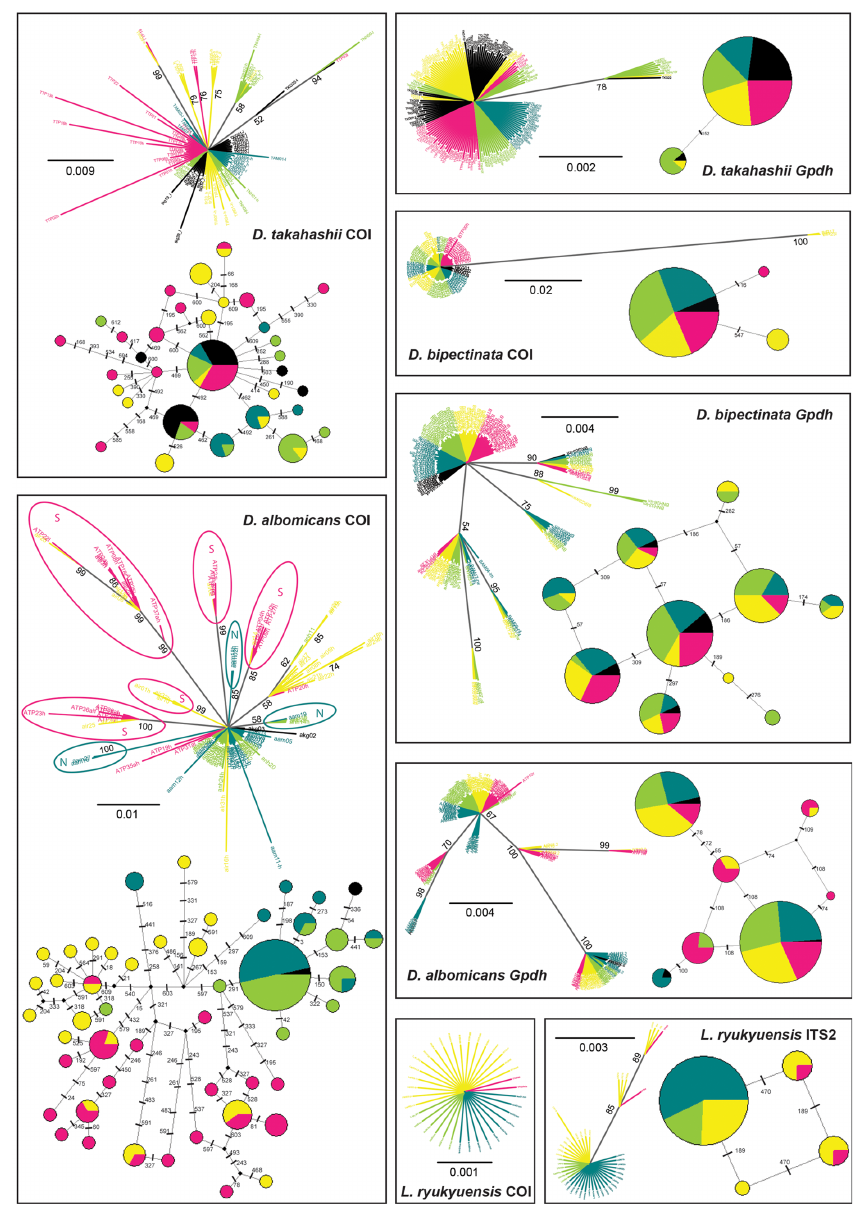
Fig 3. Unrooted consensus trees estimated with Bayesian inference and MJ networks. Trees and networks for D . takahashii COI (612 bp) and Gpdh (431 bp), D . bipectinata COI (574 bp) and Gpdh (340 bp), D . albomicans COI (611 bp) and Gpdh (401 bp), and L . ryukyuensis COI (649 bp) and ITS2 (586 bp) are given. Colors represent different populations: KG (black), AM (blue), NH (green), IR (yellow), and TP (red). Posterior probabilities of 0.5 or greater are